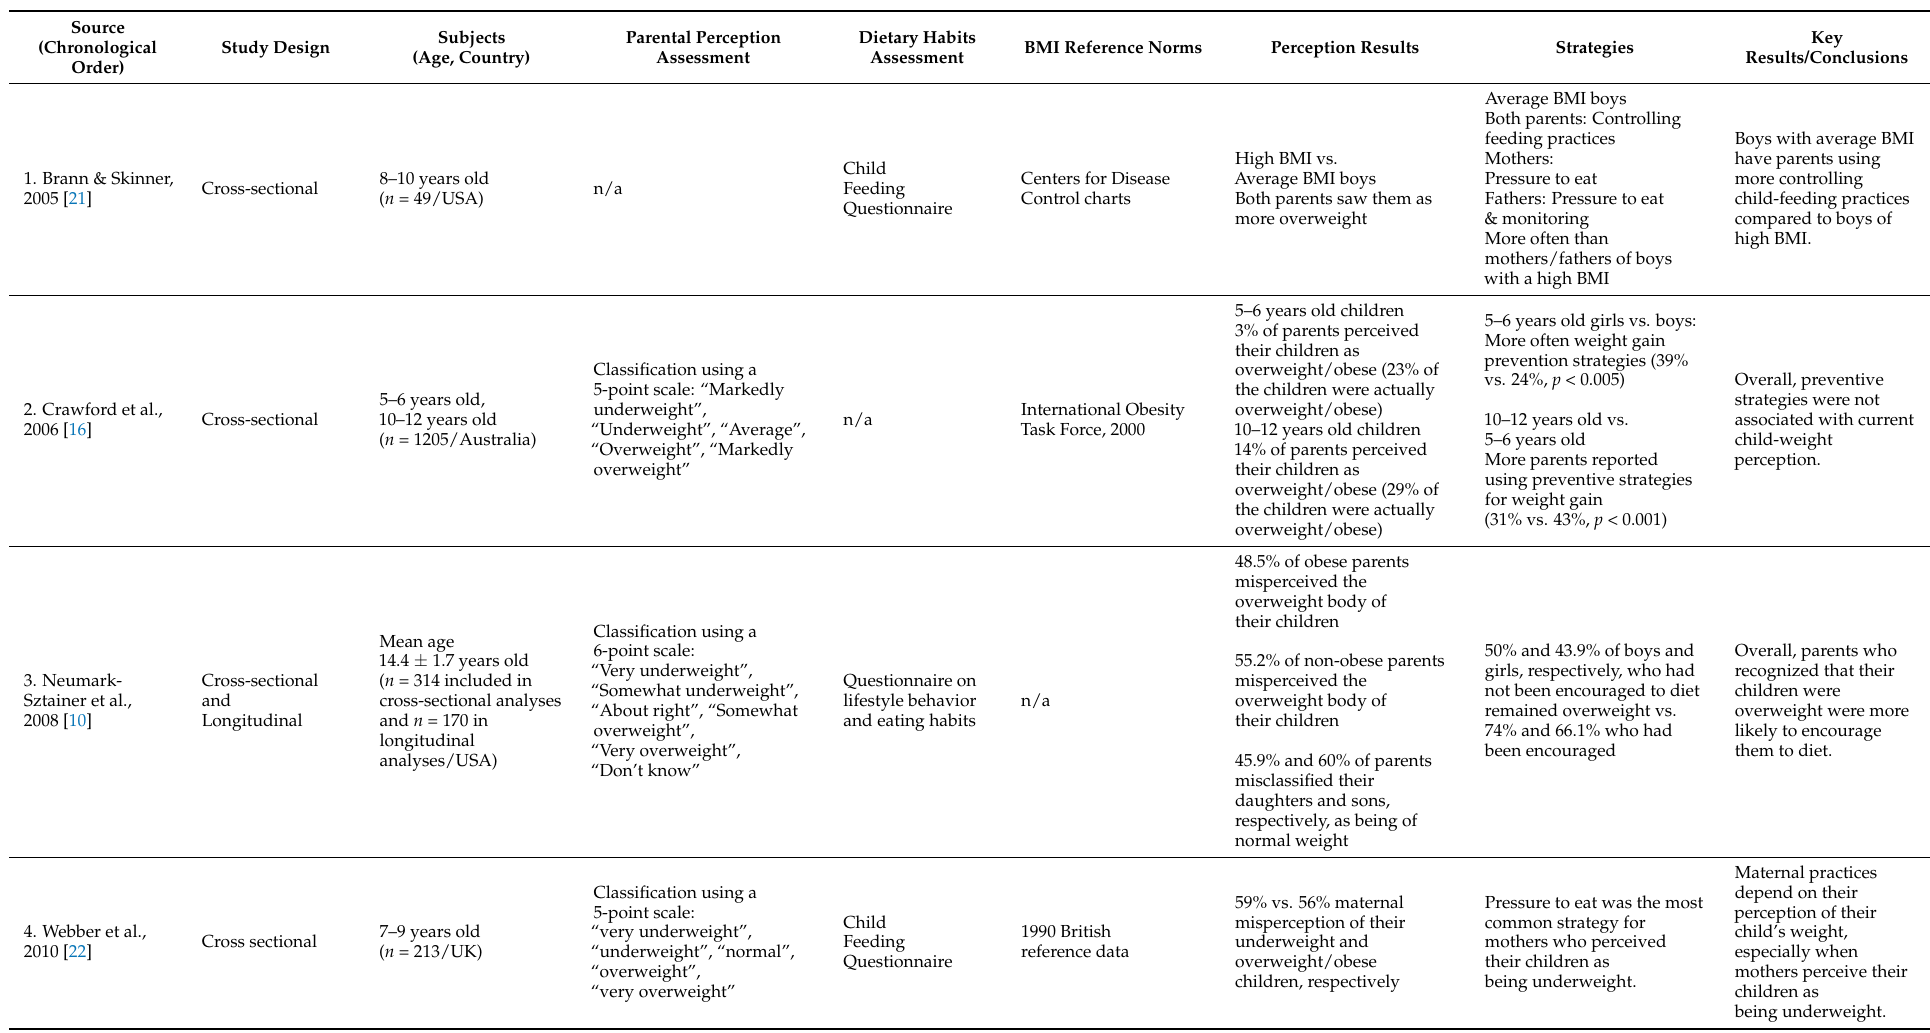
Table 1. Characteristics of the 16 retained studies which assess the relationship between parental weight misperception and child’s eating habits and weight loss